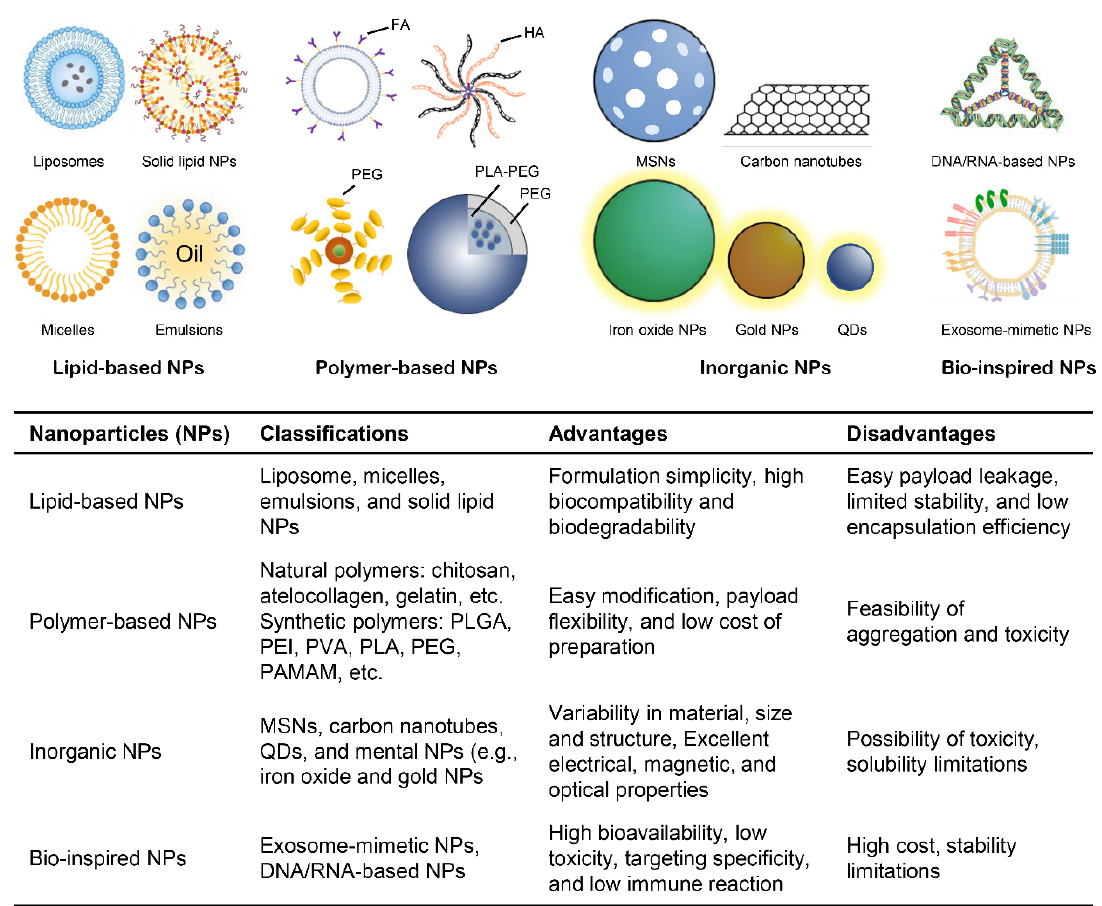
Figure 5. Classes of RNAi–delivered nanoparticles. FA, Folate; HA, Hyaluronic acid; PEG, Polyethylene glycol; PLA, Polylactic acid; MSNs, Mesoporous silica nanomaterials; PLGA, Polylactic–co–glycolic acid; PVA, Polyvinyl alcohol; PAMAM, Polyamidoamine; QDs, Quantum dots.